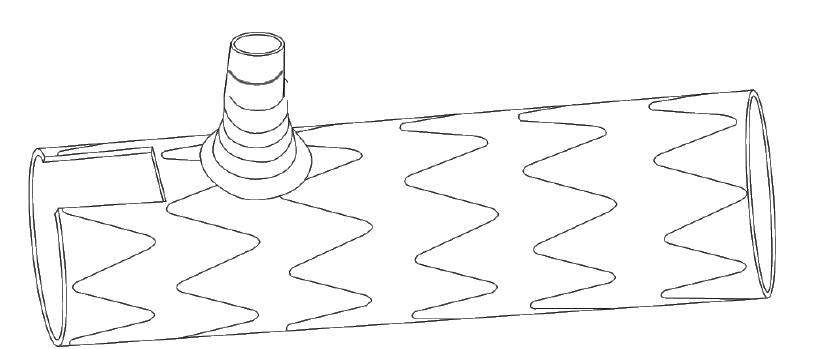
Fig. 6 - The stent excluded the